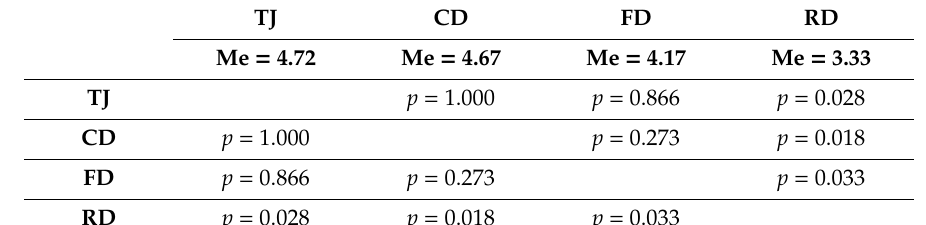
Table 5. The result of multiple comparisons of the effective value of vRMS in the 500 Hz–2 kHz frequency band in skulls with RD vs. skulls with TJ, CD, and FD with the Dunn test. Significant differences of at least p < 0.05 were noted.